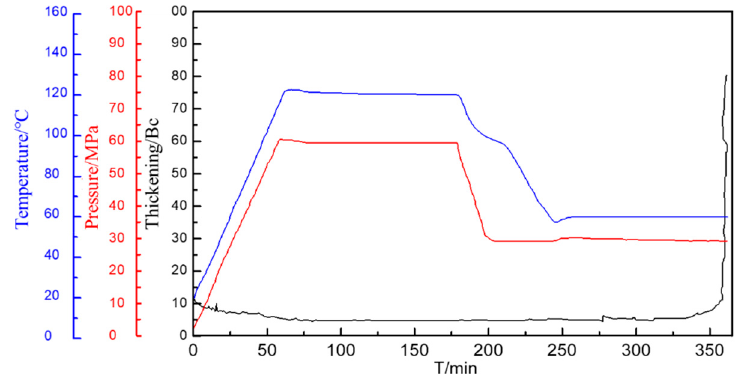
Figure 8. Thickening curve of polymeric ion retarder from 120 °C to 60 °C.